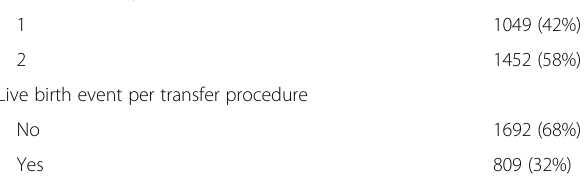
Predicting sequential outcomes Table 1 Characteristics of the clinical dataset analysed in the